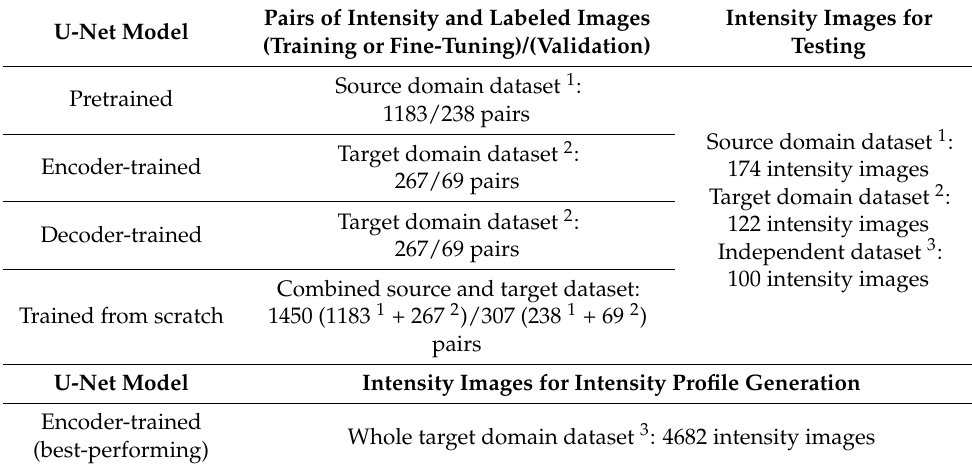
Table 1. Datasets used for training or fine-tuning, validation, testing, and intensity profile generation of various U-net models.